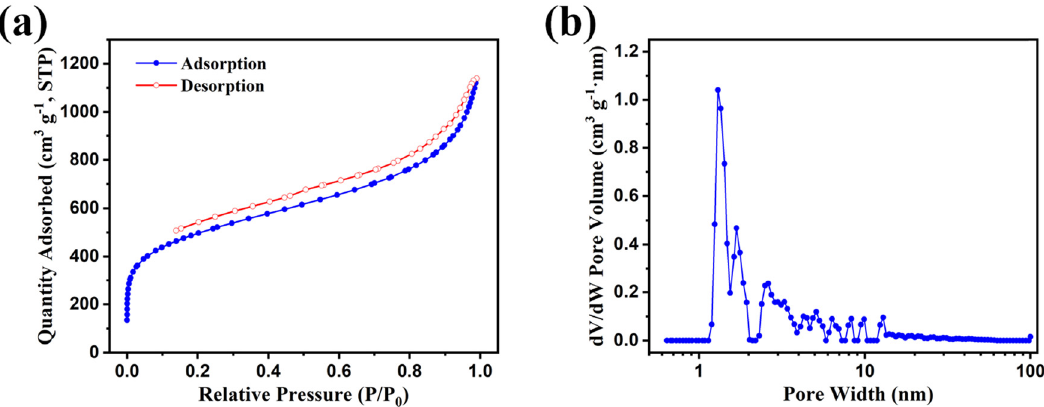
Figure 3: ( a ) Nitrogen adsorption/desorption isotherms and ( b ) pore size distributions of HCP - TPB simulated by nonlocal density functional theory model.